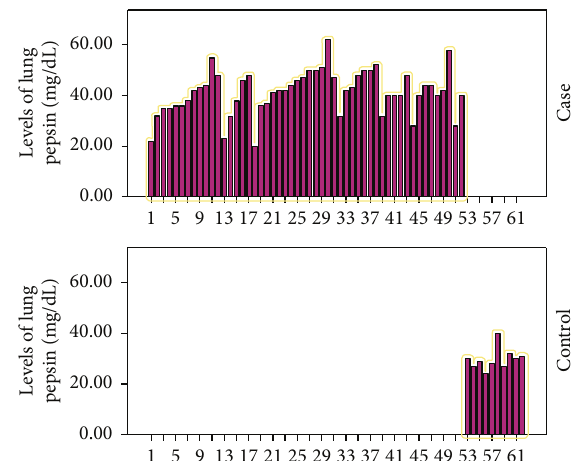
Figure 1: Lung pepsin levels in wheezy infants and healthy control.